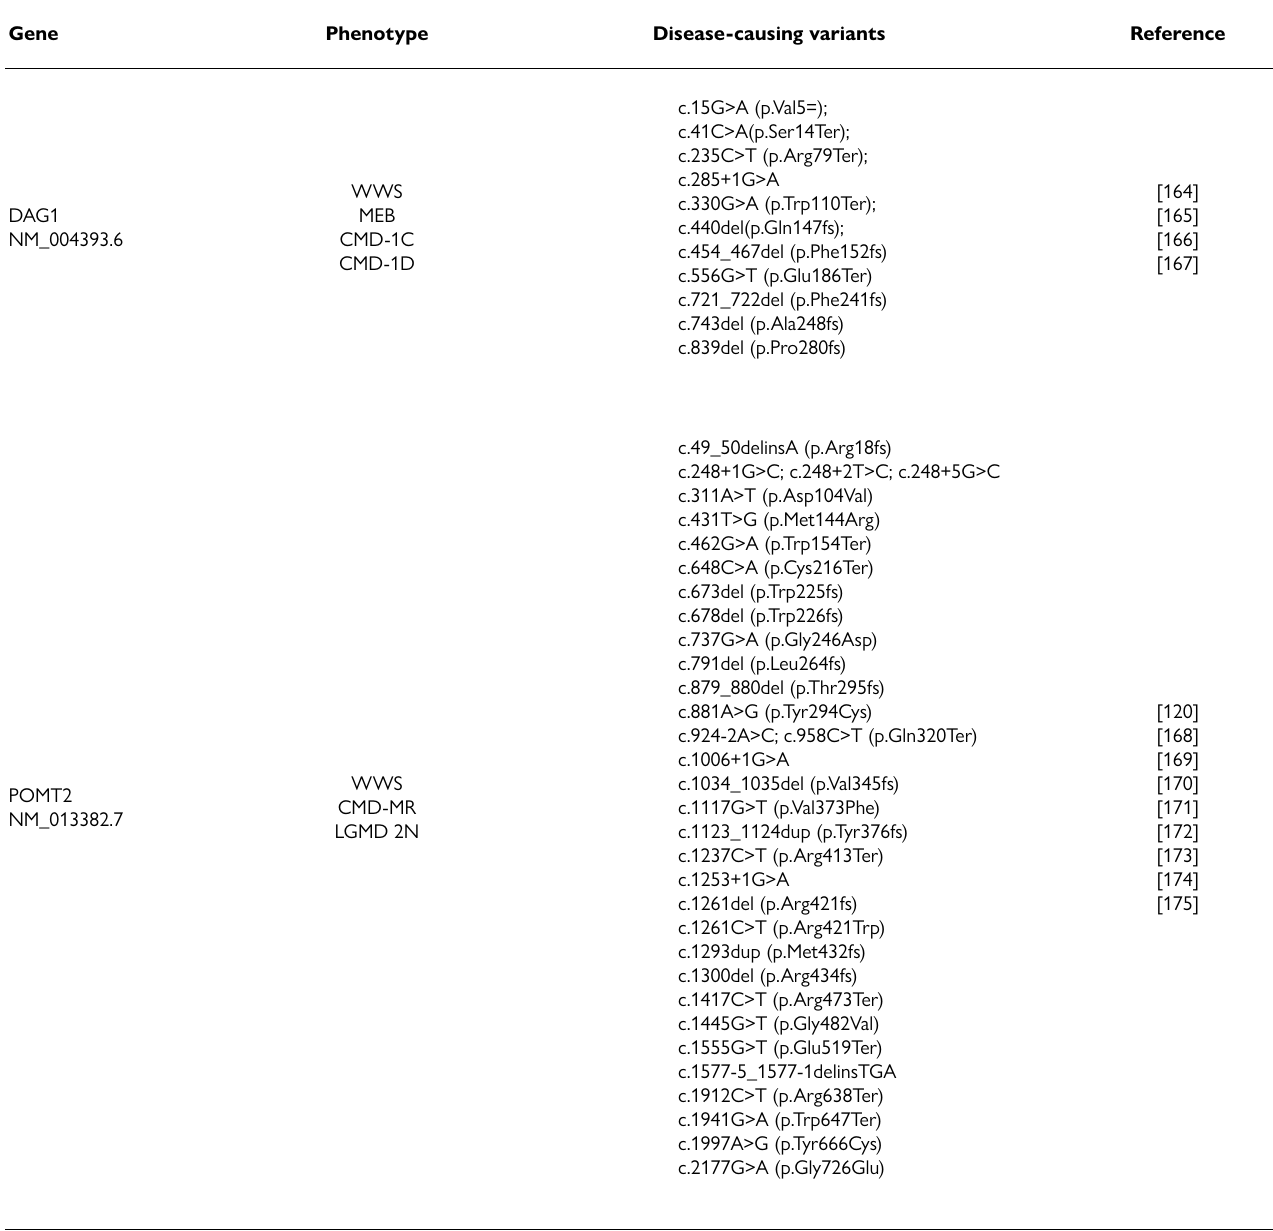
Table 3. DISEASE-CAUSING VARIANTS associated to dystroglycanopathies Phenotypes. These variants are interpreted as pathogenic in ClinVar (Genomic variation as it relates to human health). NM_ correspond to NCBI Reference Sequence used in the construction of this